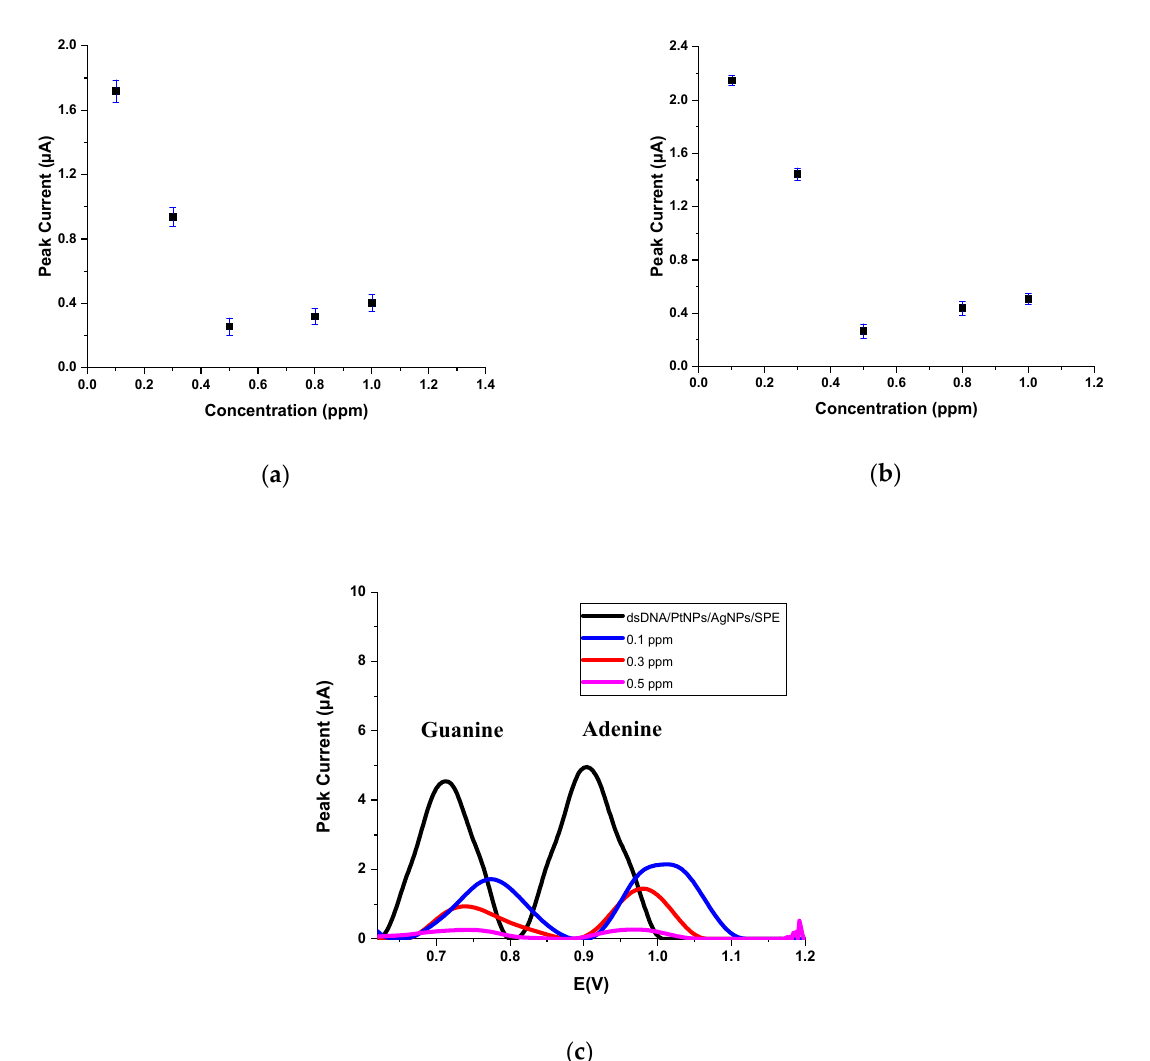
Figure 7. The effect of IDA concentration on the signal of ( a ) dGuo and ( b ) dAdo; and ( c ) DP voltammograms of dsDNA/PtNPs/AgNPs/SPE (black) with different IDA concentration in pH 4.70 AB; 0.1 ppm (blue), 0.3 ppm (red), 0.5 ppm (pink).